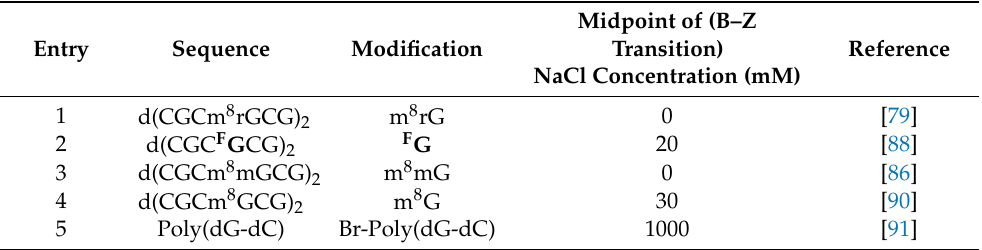
Table 2. The midpoint of NaCl concentrations for the B to Z transition of DNA in various base- modified monomers incorporating d(CGCGCG) 2 and